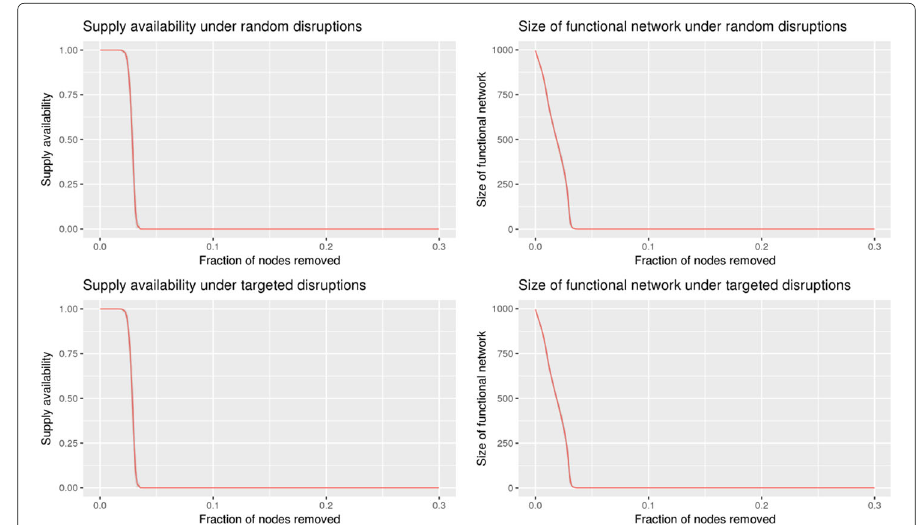
Fig. 10 Artificial supply